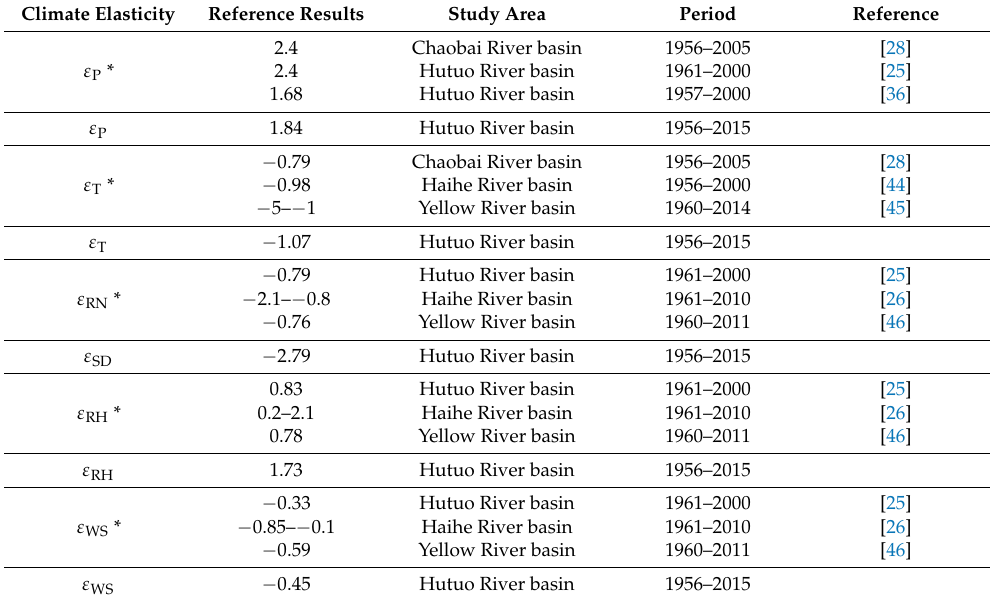
Table 7. Comparison between the climate elasticity to climatic elements between the reference results and the results from the present study.